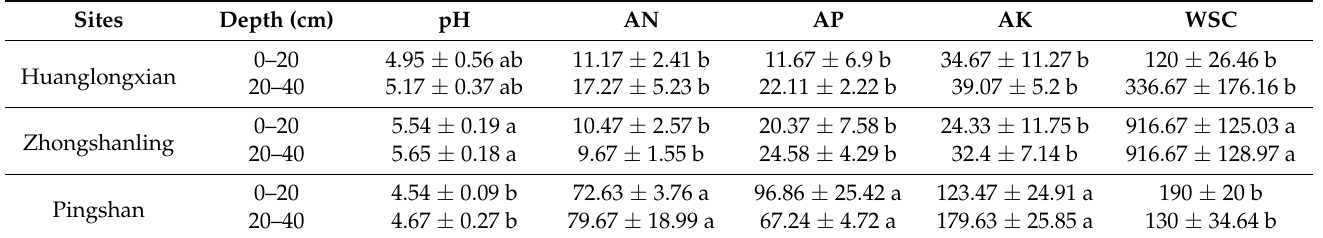
Table 2. Soil chemical properties in the three sampling